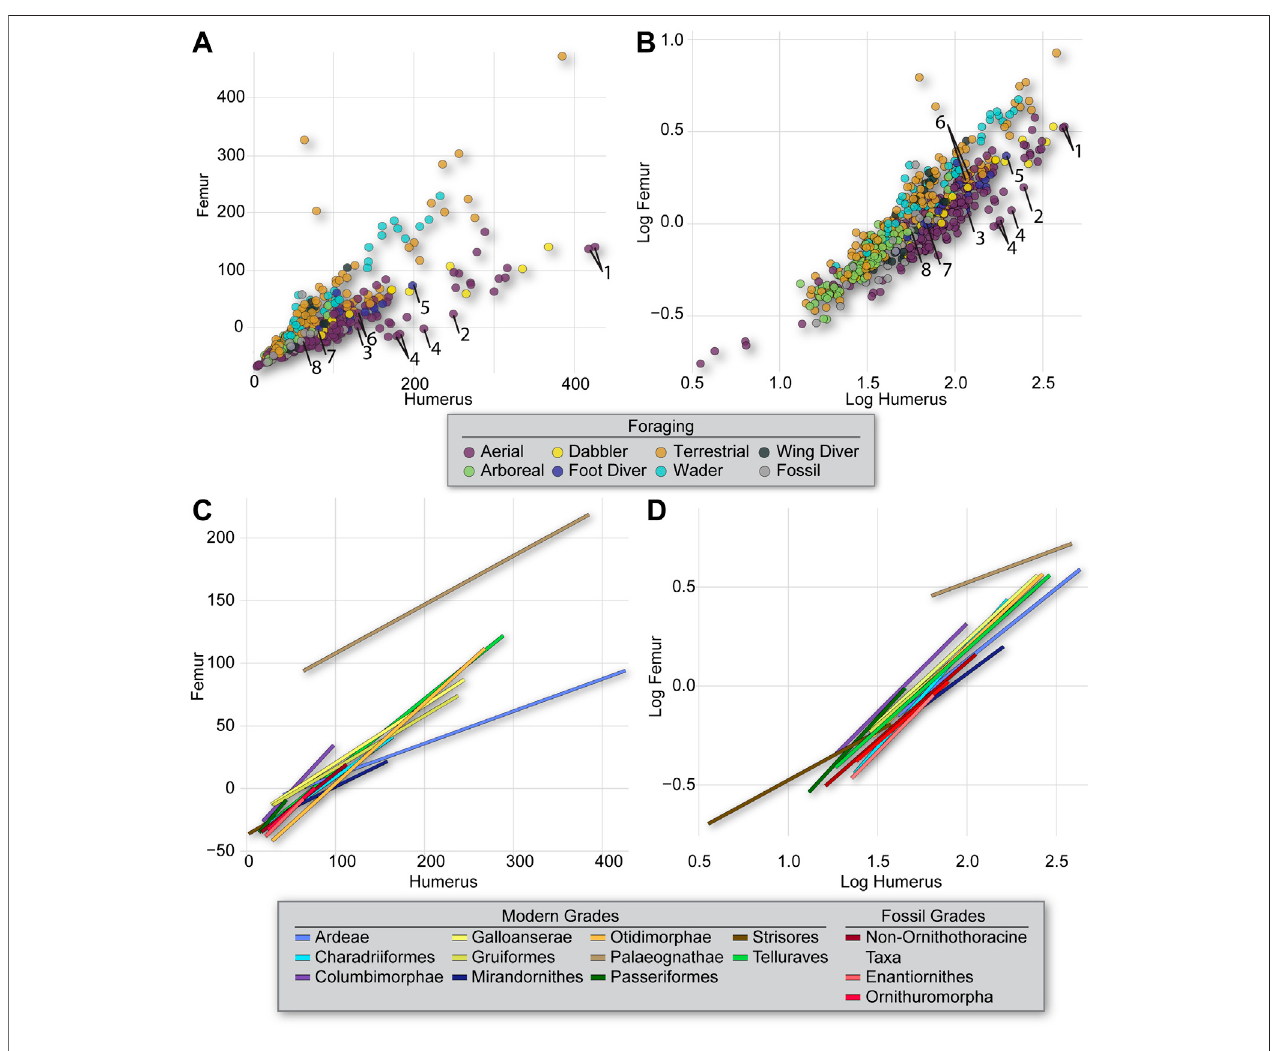
FIGURE 5 | Interlimb proportions (humerus vs. femur) from all specimens coded by foraging strategy (A,B) and slopes for phylogenetic groupings (C,D) resulting from the PGLS regression of the untransformed (A,C) and log 10 -transformed (B,D) data. Notice clear differences among the regression slopes for the foraging groups and clades when using untransformed data (A,C) and their collapse when using log 10 -transformed data (B,D) . Taxa are numbered as follows in (A,B) : Tubenoses – 1 Diomedea , 2 Phoebetria, 3 Calonectris ; Frigatebird – 4 Fregata ; Loon – 5 Gavia ; Grebe – 6 Aechmophorous, 7 Podiceps, 8 Rollandia .